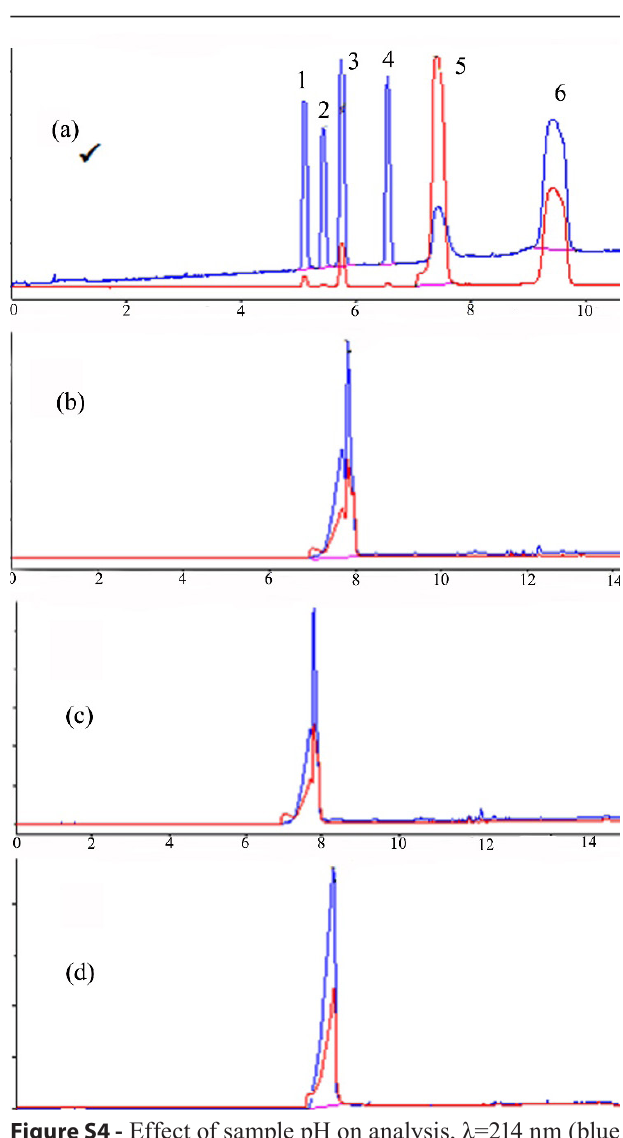
Figure S4 - Effect of sample pH on analysis, λ=214 nm (blue line), λ=257 nm (red line), a)pH 7.0 b)pH 9.0 c)pH 11.0 d) pH 5.0 e)pH 3.0, Conditions: Hydrodynamic injection P mbar, Separation Voltage=30 kV, Capillary diameter: 75 μm, BGE: 75 mmol L -1 Sodium borate (pH: 8.0) buffer-15% ACN, Peaks: 1)DEX 2)EPH 3)CHL 4)PSE 5)4-AP